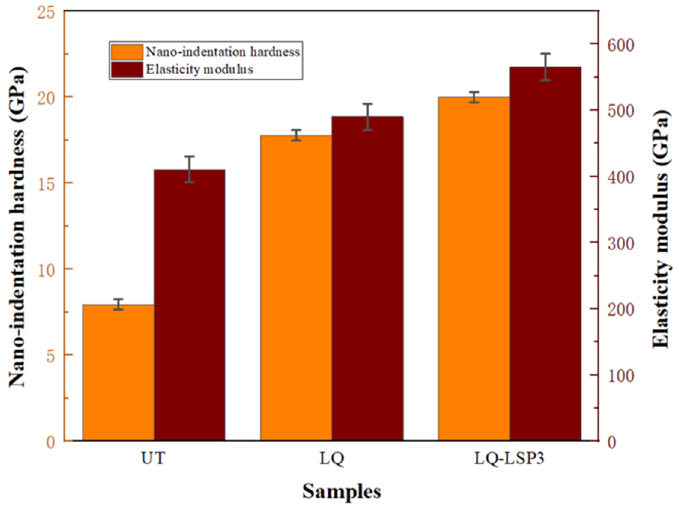
Figure 11. Nanohardness and elastic modulus of samples treated by different processes .